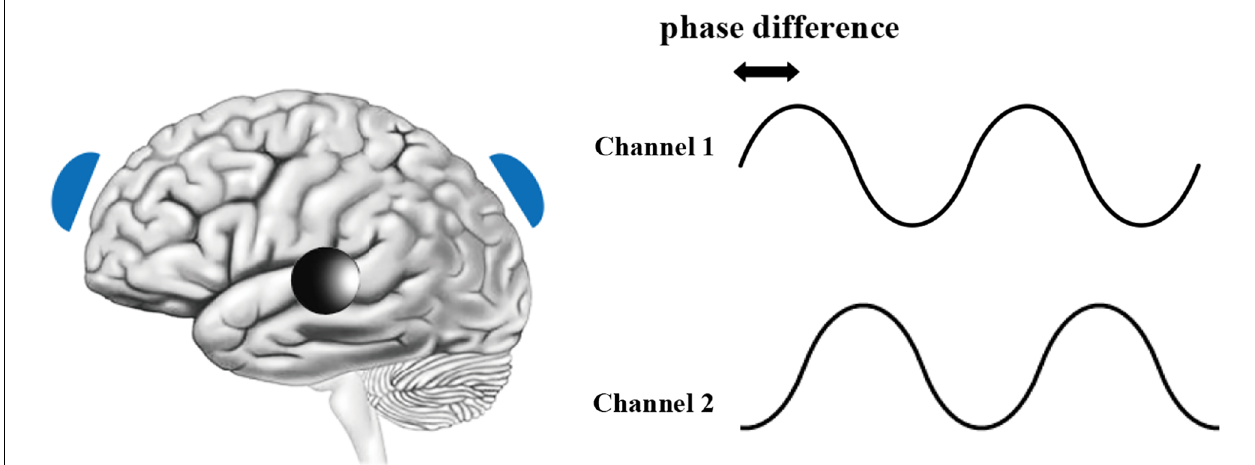
FIGURE 3 | Schematic diagram of phase-shifted tACS.